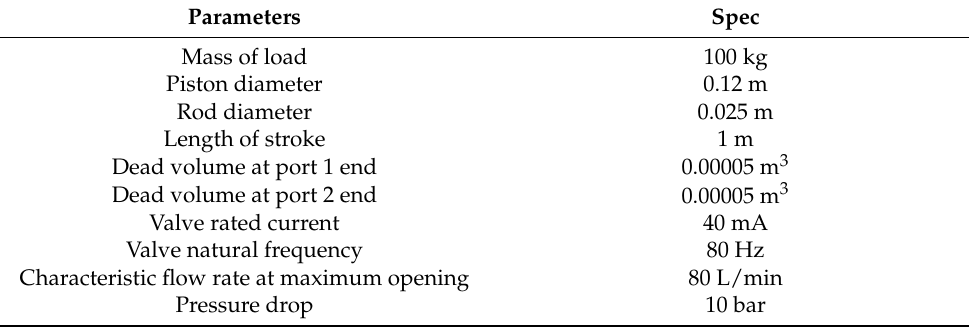
Table 1. Basic parameters of